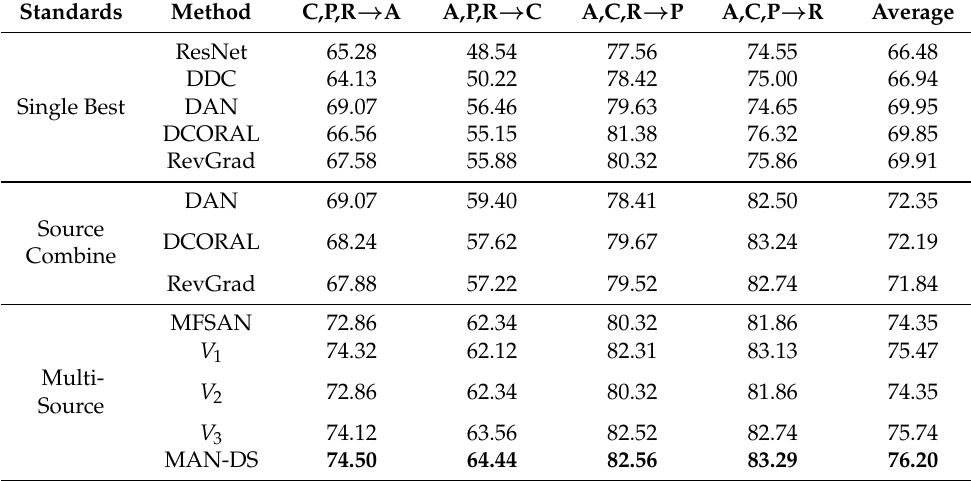
Table 3. Performance comparison of classification accuracy (%) on Office-Home